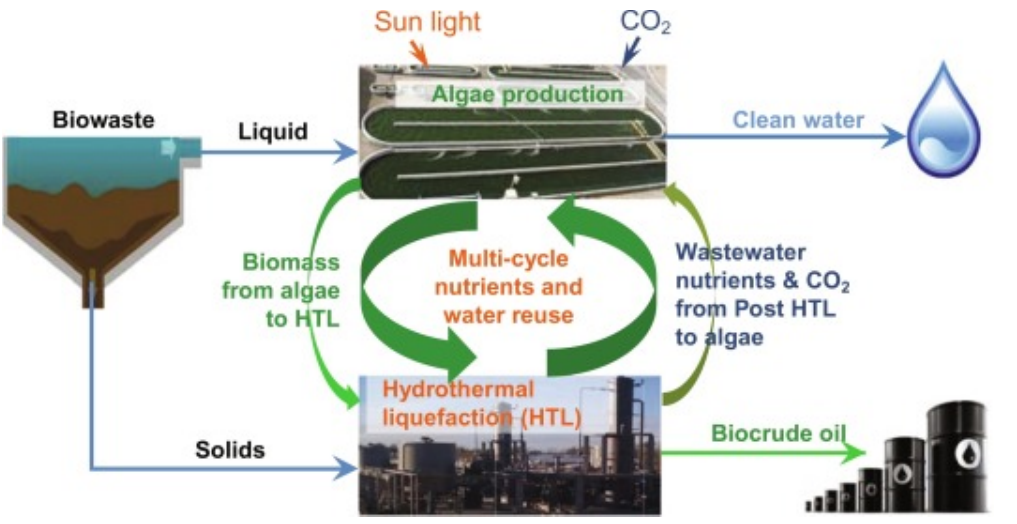
Figure 1. Process for a protein-containing feedstock for hydrothermal liquefaction [77]. Table 4. Summary of pretreatment methods for HTL feedstocks that contain protein contents.